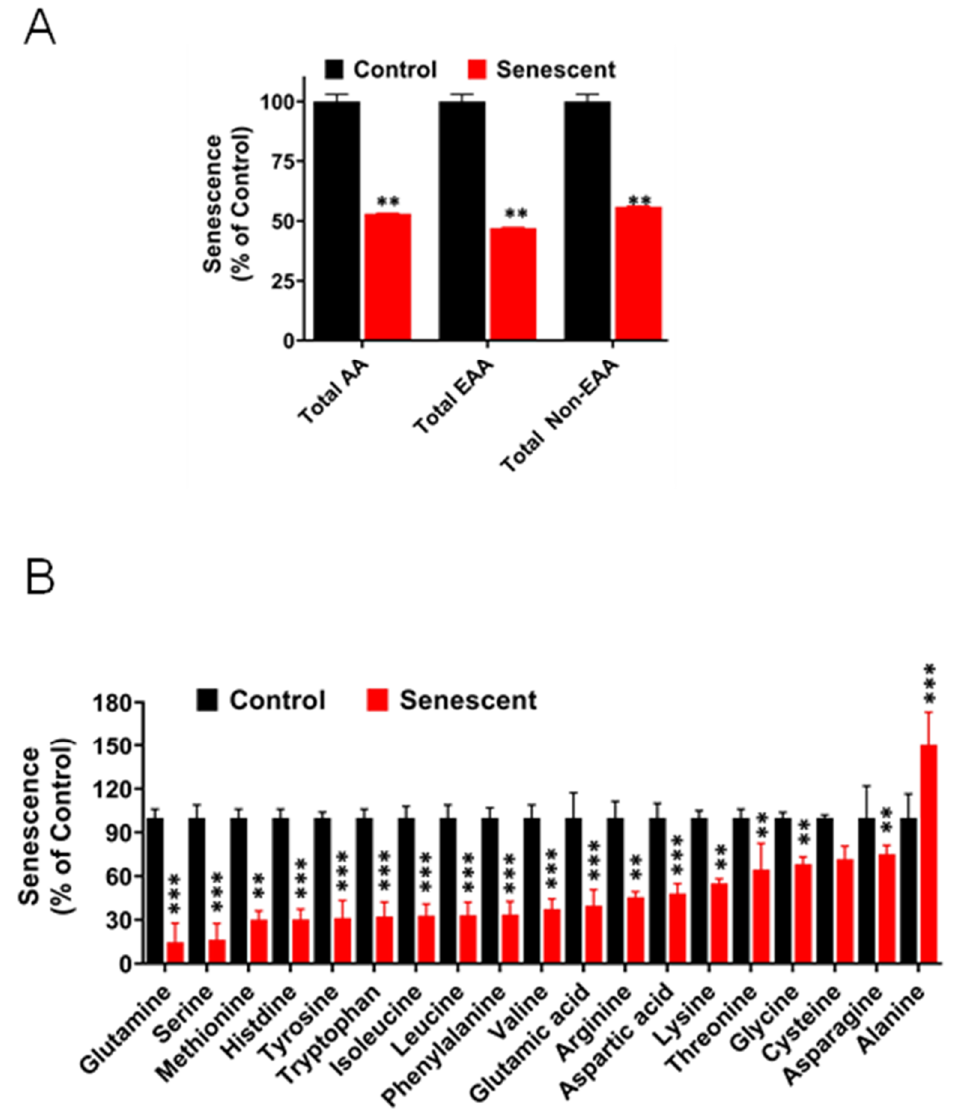
Figure 9. ( A , B ). Levels of amino acids in control and senescent HCT-116 cells. ( A ) Total amino acids (AA), essential amino acids (EAA), and nonessential amino acids (non-EEA) in control and senescent cells. ( B ) individual amino acids levels in control and senescent cells. Metabolites in senescent cells are expressed as percent of control based on protein concentration of samples. Results are ± SD of triplicate samples. Actual values obtained from analysis (nmoles/g protein) including p values and significance is presented in Table S2. ** p value < 0.01, *** p value <